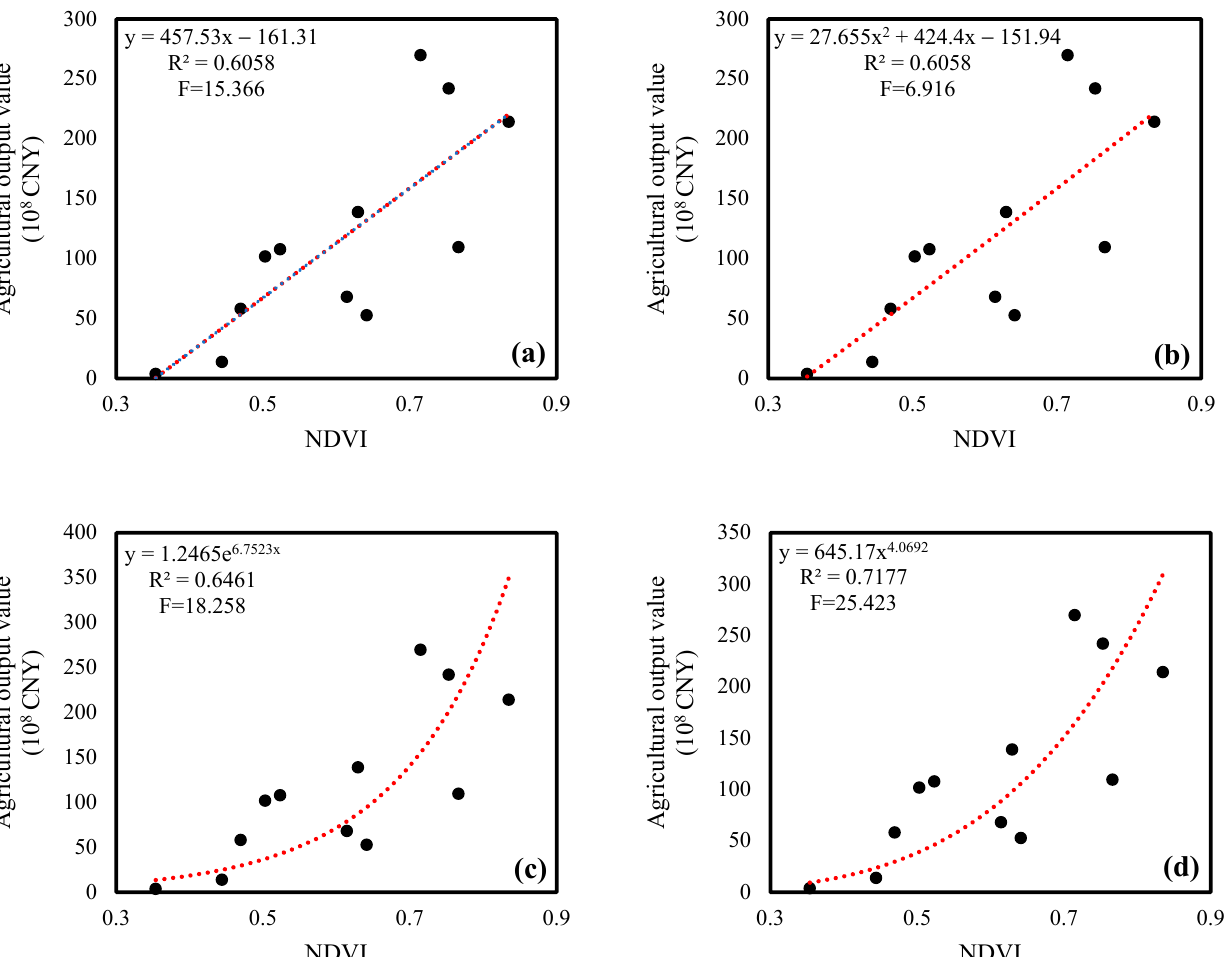
Figure A1. Statistical relationship between NDVI and agricultural output value: ( a ) Linear algorithm; ( b ) quadratic polynomial algorithm; ( c ) exponential algorithm; ( d ) power function algorithm.